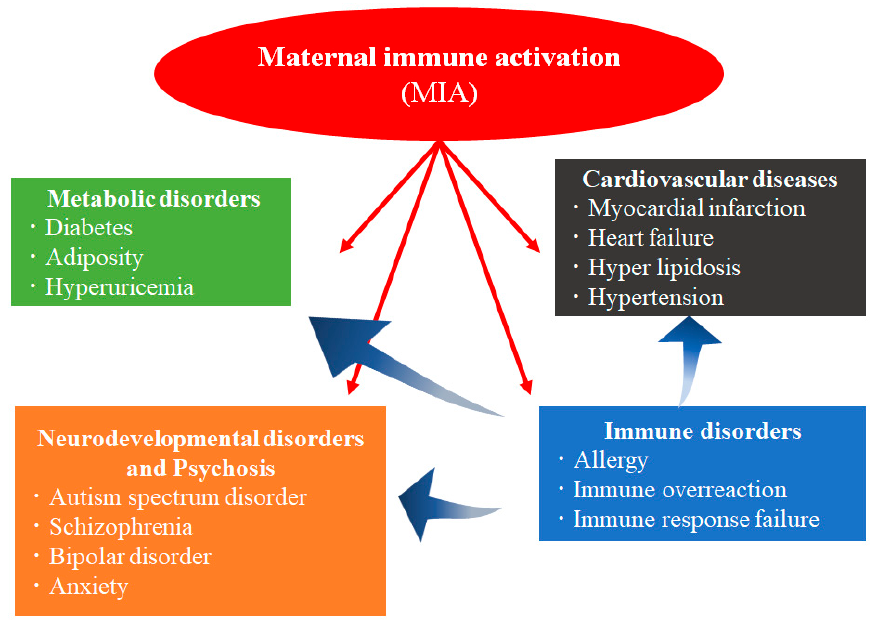
Figure 1. Effects of exposure to MIA in offspring. Exposure to MIA in the prenatal period induces various diseases, such as metabolic, neurodevelopmental, immune system disorders, and cardio- vascular diseases. MIA is one of the risk factors for developing these diseases and disorders in the postnatal period. Immune system disorders might cause these diseases due to MIA exposure in the prenatal